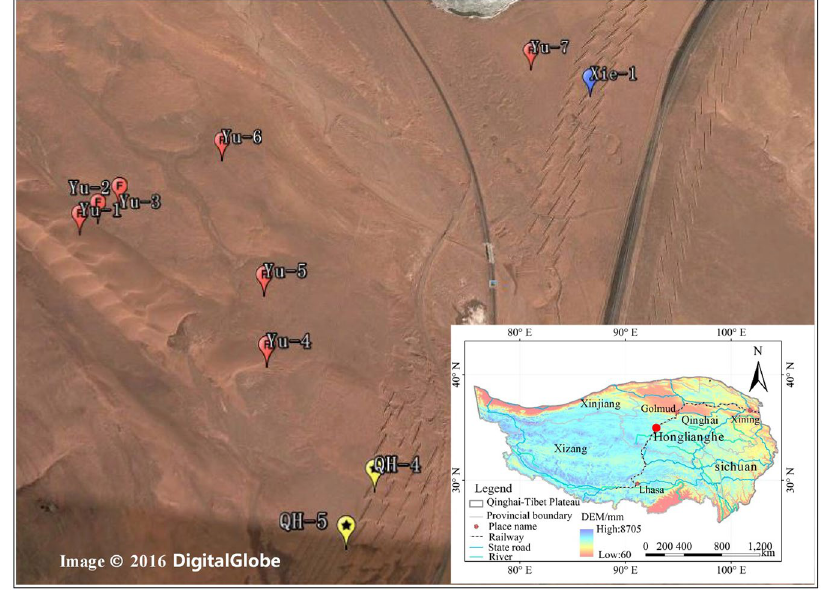
Figure 1. Map of observation sites at the Honglianghe River Basin along the Qinghai-Tibet Highway of the interior Qinghai-Tibet Plateau (the map was edited and generated using Google Earth, Image© 2016 DigitalGlobe; the small map was edited and generated using ArcGIS 8.0, which is American GIS Software (http://www.esrichina.com.cn/softwareproduct/ArcGIS/); Qingbai Wu created this map).